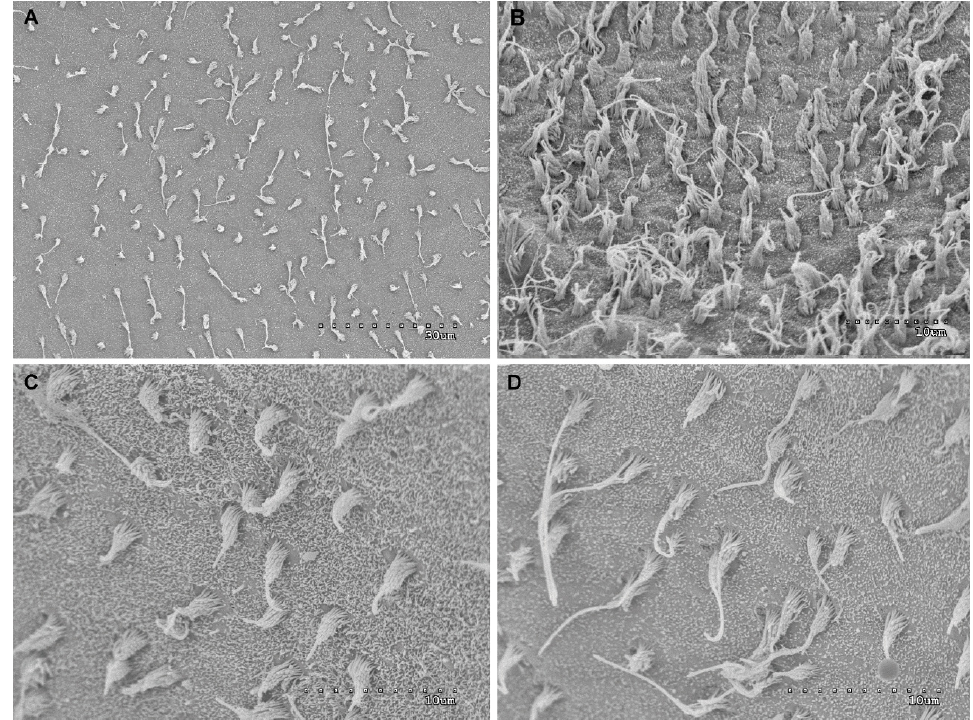
Figure 17. SEM. Salmon inner ear. Utricle sensory epithelium. ( A ) Control. ( B ) 3 weeks after sound exposure. ( C ) 6 weeks after sound exposure. ( D ) 12 weeks after sound exposure. By comparison with control animals, the images of the saccule epithelium show healthy sensory hair cells in all cases of exposed animals. Scale bar: ( A ) = 30 µm. ( B – D ) = 10 µm.